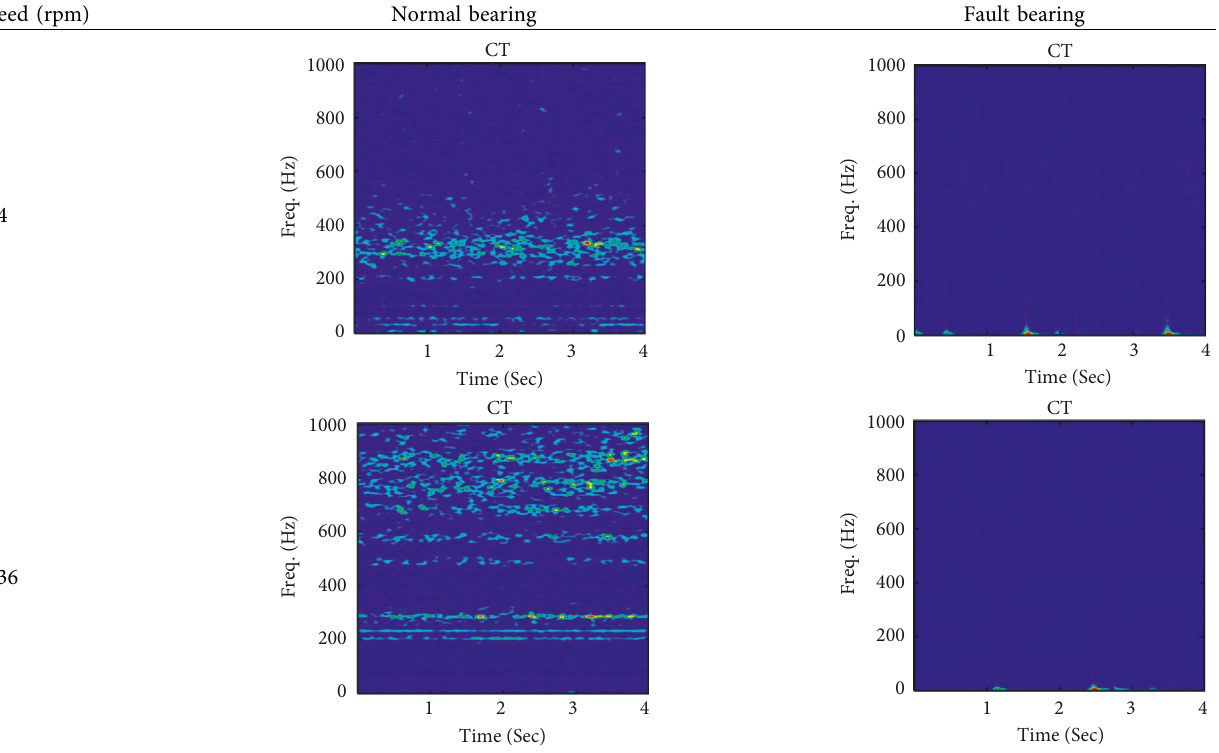
Table 9: Time-frequency diagram of vertical acceleration signal.